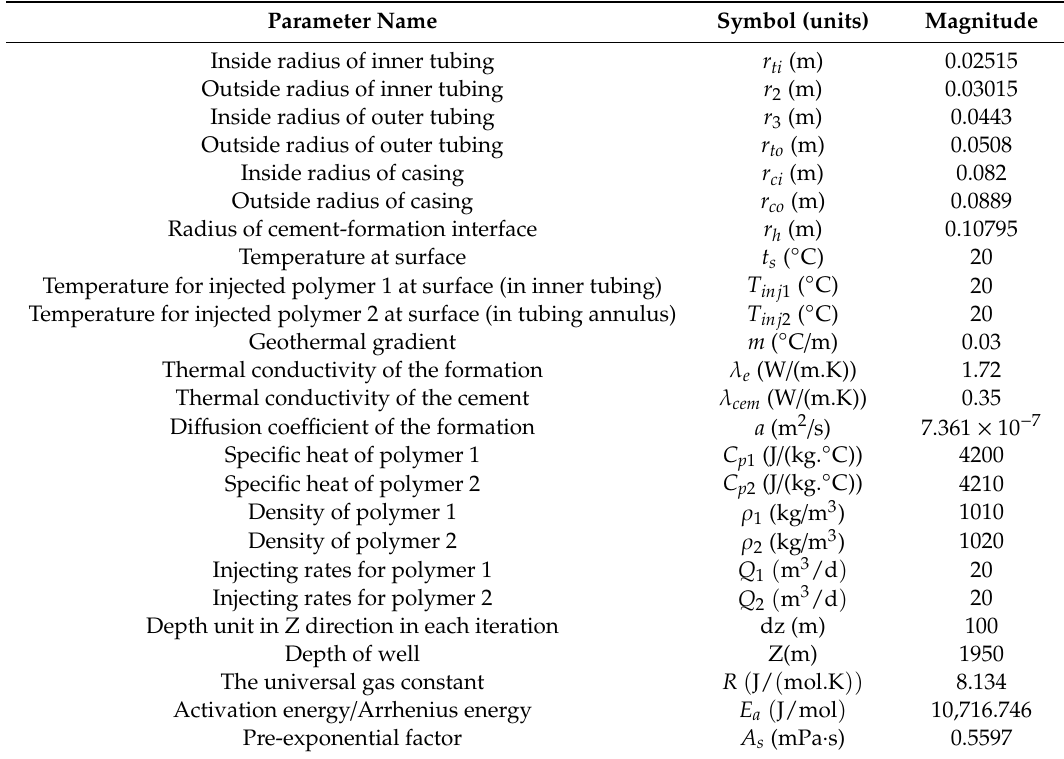
Table 1. Nomenclature with the magnitude of